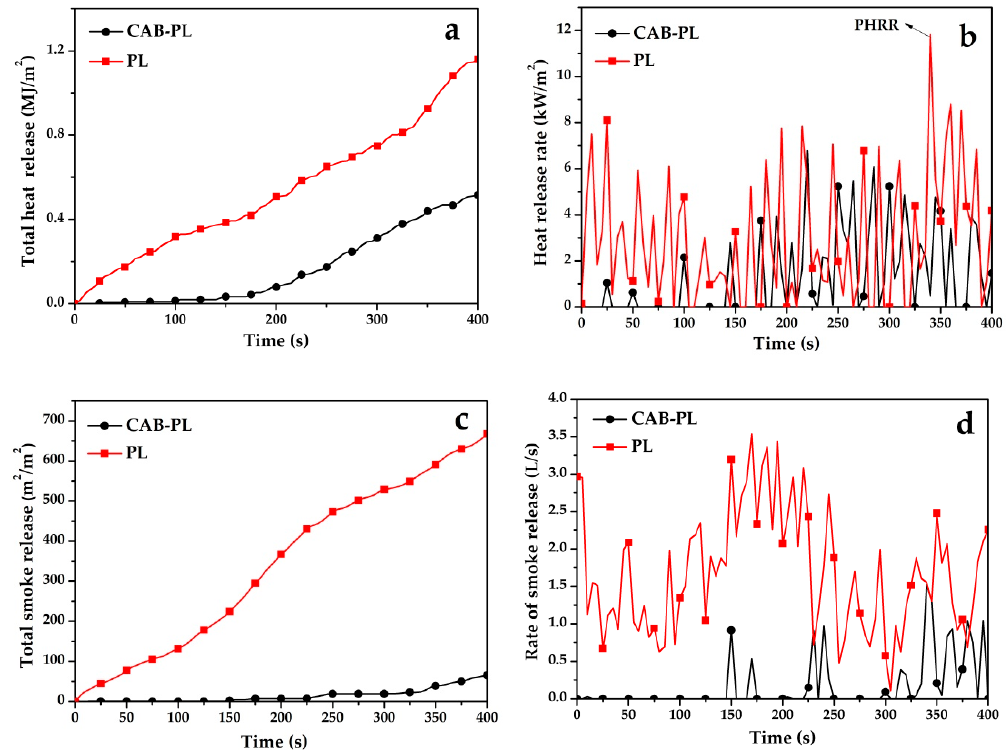
Figure 4. ( a ) Total heat release (THR), ( b ) heat release rate (HRR), ( c ) total smoke release (TSR), and ( d ) rate of smoke release (RSR) curves of the CAB-PL and PL changing over